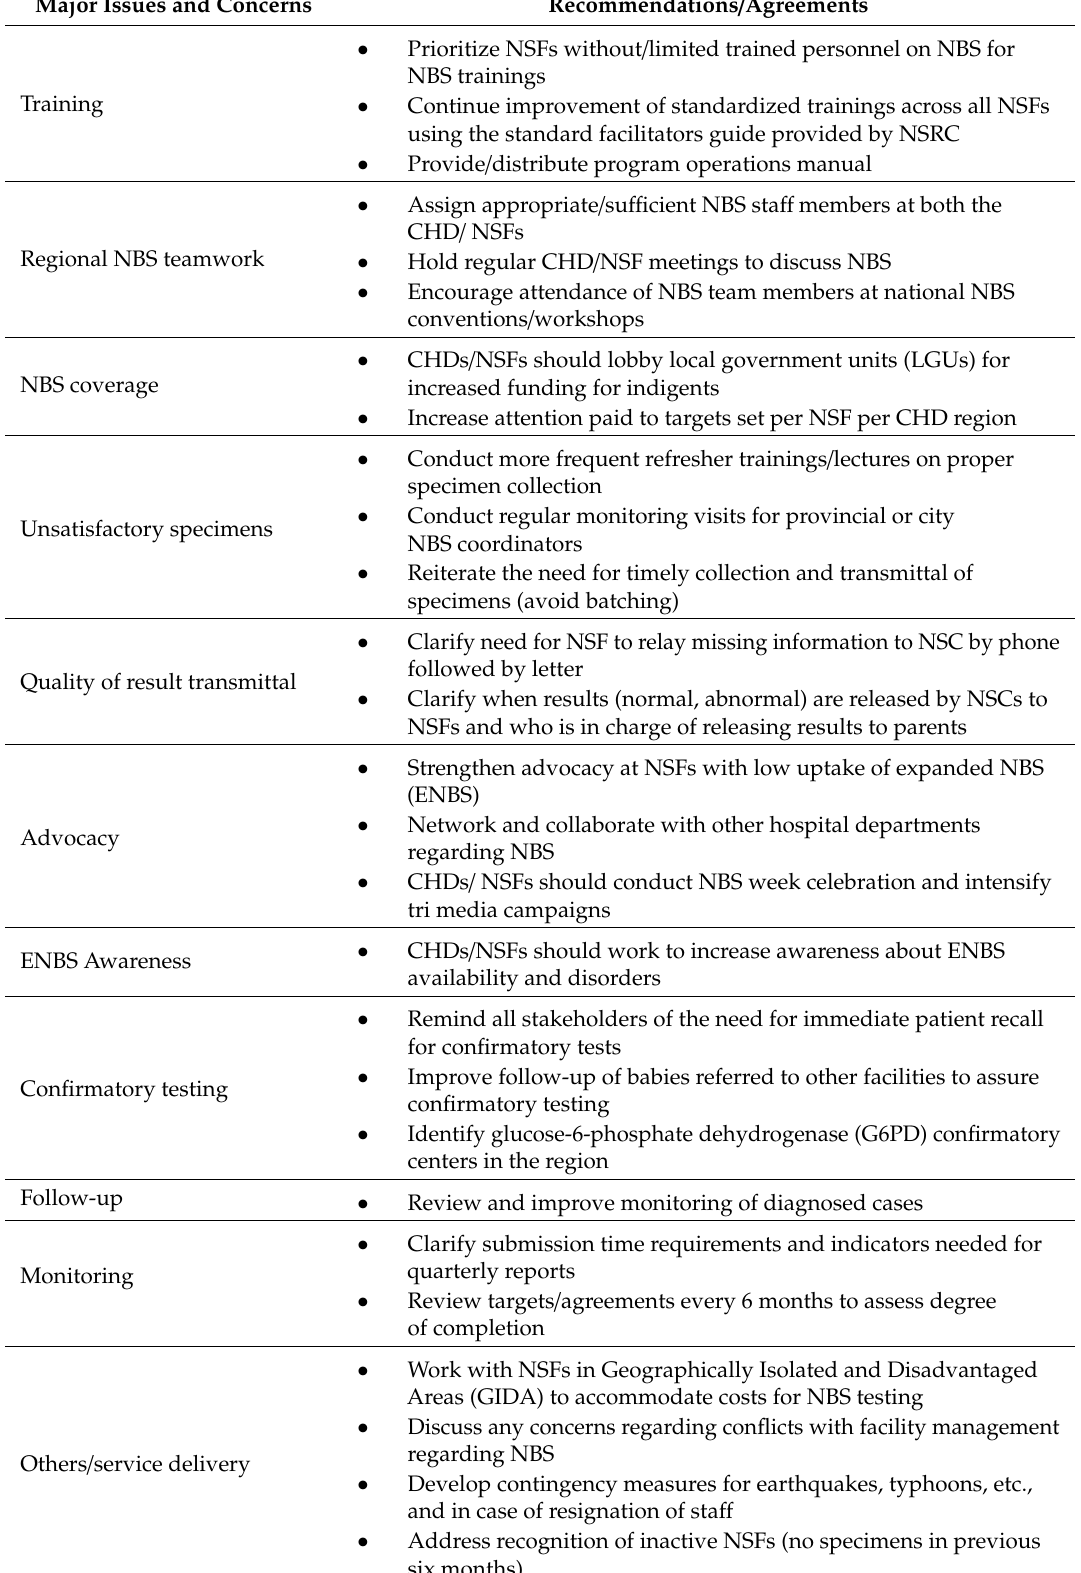
Table 2. Major issues and concerns arising at regional CHD meetings with